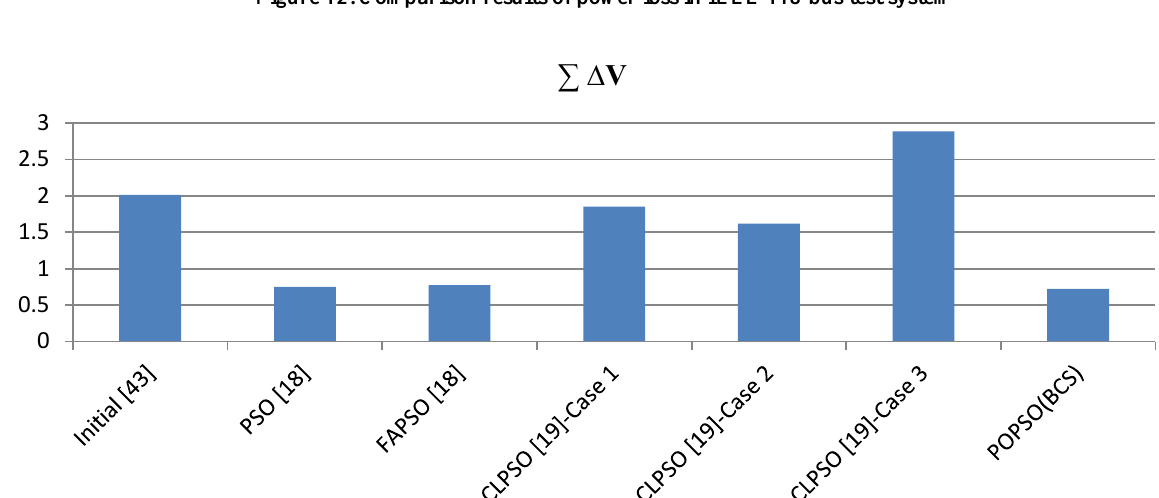
Figure 12. Comparison results of power loss in IEEE 118-bus test system